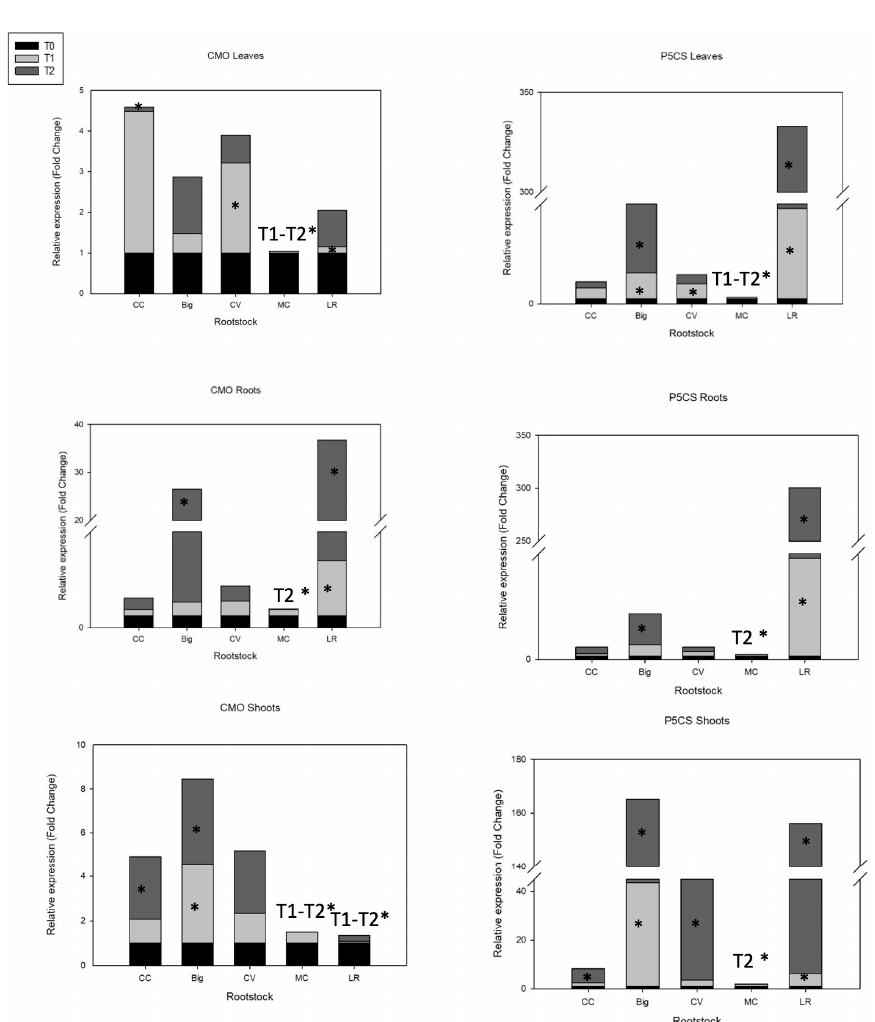
Figure 3. Expression profiles of CMO and P5CS genes of ‘Hernandina’ clementine ( Citrus clementina hort. ex Tanaka) (willowleaf mandarin ( C. deliciosa ) × sweet orange ( C. sinensis (L.) Osbeck)) grafted on 5 citrus rootstocks in response to salt stress. Big: sour orange ( C. aurantium L.); CC: Carrizo citrange ( C. sinensis × Poncirus trifoliata (L.) Raf); CV: Volkamer lemon ( C. volkameriana V. Ten. & Pasq.); LR: Rangpur lime ( C. limonia Osbeck); MC: Cleopatra mandarin ( Citrus reshni hort. ex Tanaka). For each combination (rootstock/’Hernandina’), stacked panels show gene expression in plant tissues (leaves, shoots, and roots) treated with NaCl (T1: 35 mM NaCl; T2: 70 mM NaCl) relative to untreated samples (T 0 , only nutrient solution without salt treatment). Relative gene expression was calculated using 2 − ∆∆ CT method (fold change). * Significant differences for p values <